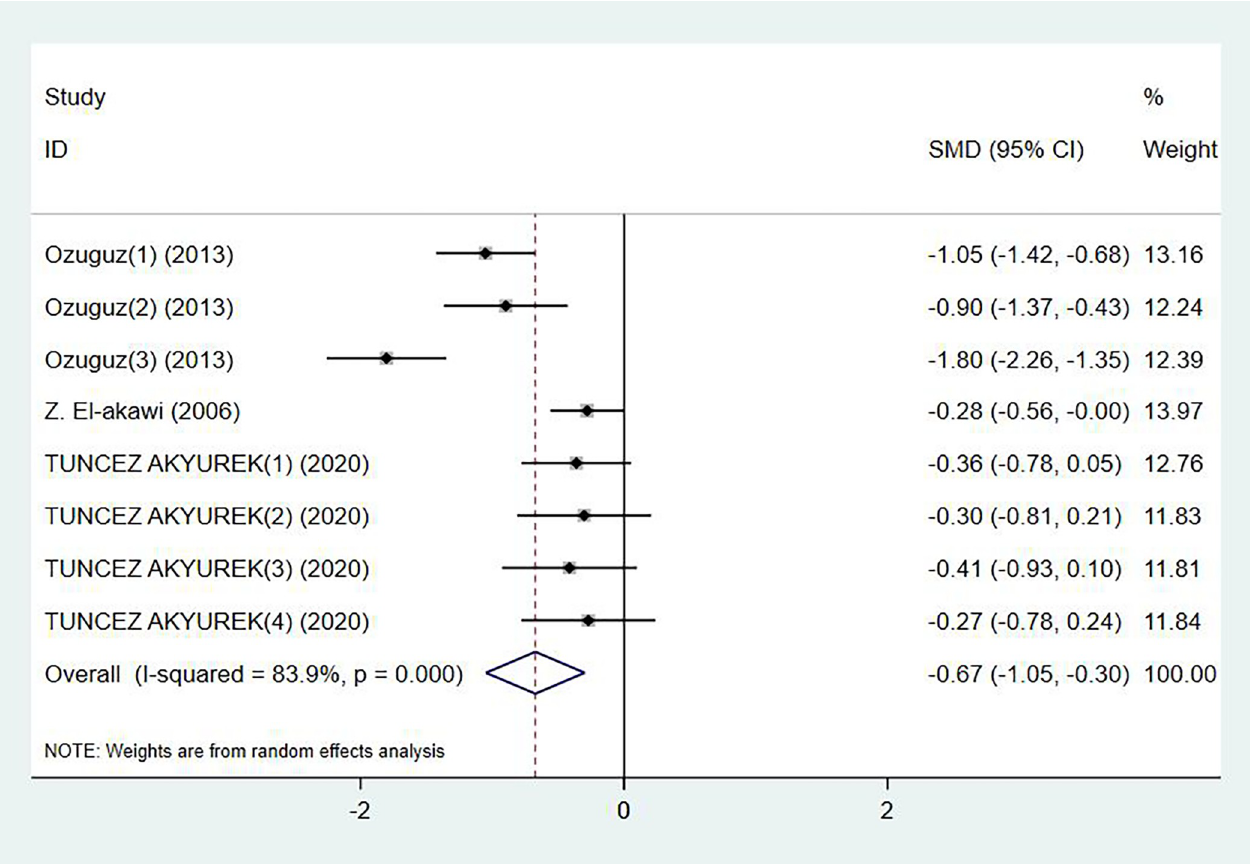
Fig 5. Forest plot in the meta-analysis of vitamin E levels and